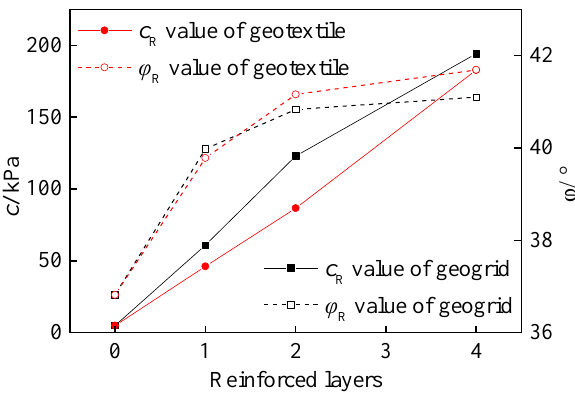
ff erent reinforced